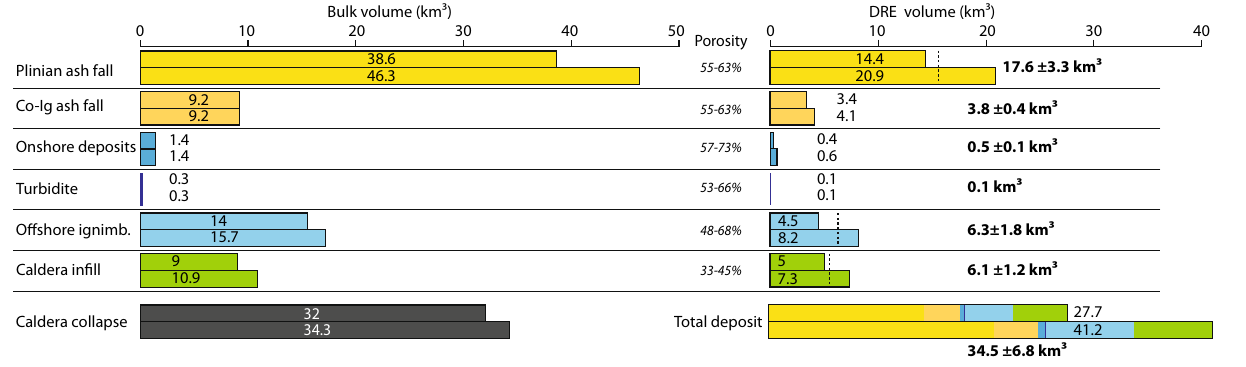
Fig. 5 | Volumetric analyses results for the Minoan eruption. Minimum and maximum estimates for the bulk and DRE-volumes for the various components of theMinoaneruptiondeposits.ConversionbetweenbulkandDRE-volumesisbased